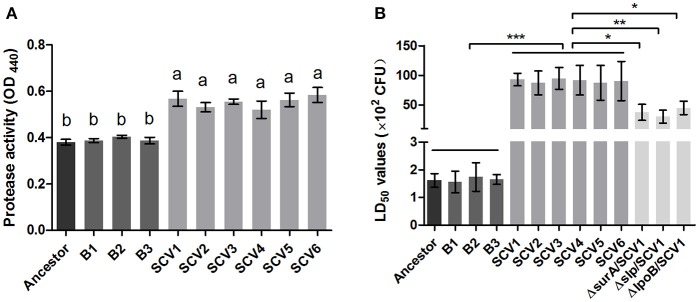
Protease activity and LD50 determination. (A) The protease activity in the culture supernatants of the ancestor, B strains (non-Tetrahymena-exposed) and SCV strains (Tetrahymena-exposed) was detected using azocasein as protease substrate and measured at OD440. Data are presented as the mean ± SD of three independent experiments, with each experiment being comprised of four individual measurements. Different lowercase letters (a, b) indicate significant differences (P < 0.05) among different bacterial strains. (B) The LD50 values of the ancestor, B strains, SCV strains, and surA, slp, lpoB gene-deletion mutants in SCV1 were calculated using a zebrafish model. Data are presented as the mean ± SD of four independent experiments. *P < 0.05, **0.001 < P < 0.01, or ***P < 0.001 indicates significant difference among different bacterial strains.